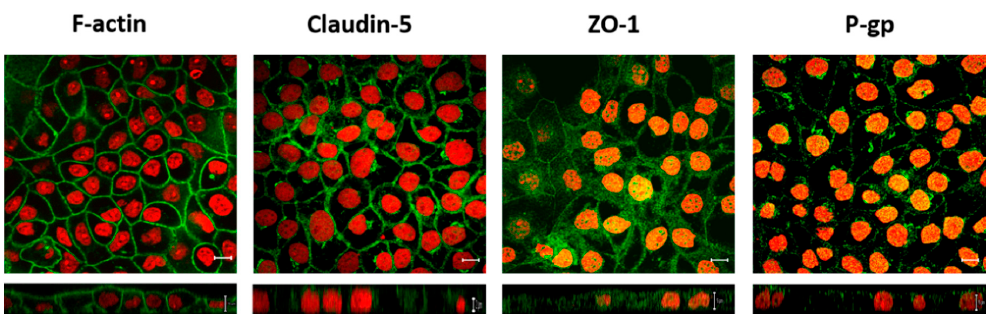
Figure 4. Localization of filamentous actin (F-actin), claudin-5, zonula occludens-1 (ZO-1) and P-glycoprotein (P-gp) in IPEC-J2 Mdr1a cells. Images show cell monolayers immuno-stained for F-actin, claudin-5, ZO-1 and P-gp (in green) and for propridium iodide (in red) for cell nuclei visibility. Upper row images show xy sections (scale bar = 10 μ m), and lower row images show xz sections of the corresponding samples. The lower row images have different scale bars: F-actin = 10 μ m, claudin-5 = 2 μ m, ZO-1 and P-gp = 5 μ m.